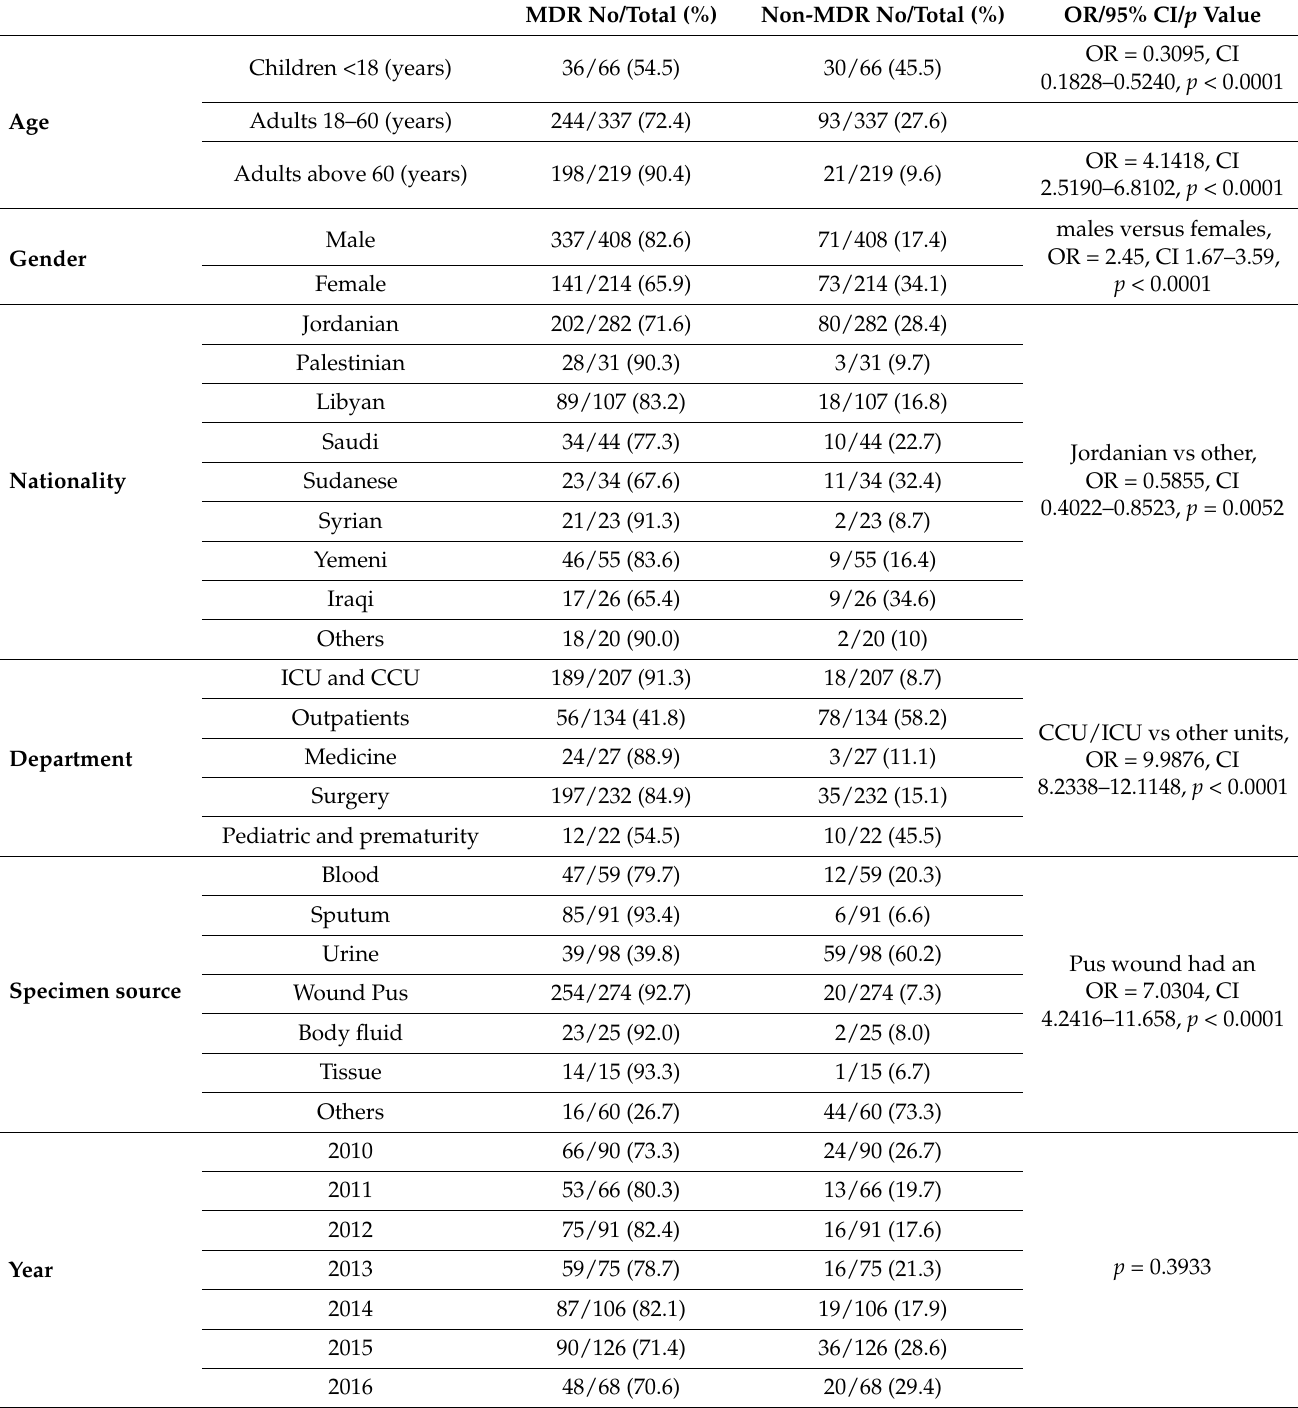
Table 2. A. baumannii MDR isolates distribution (Total n =